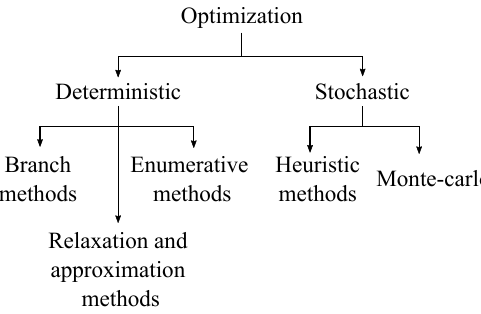
Figure 2. Overview of optimization methods (adapted from